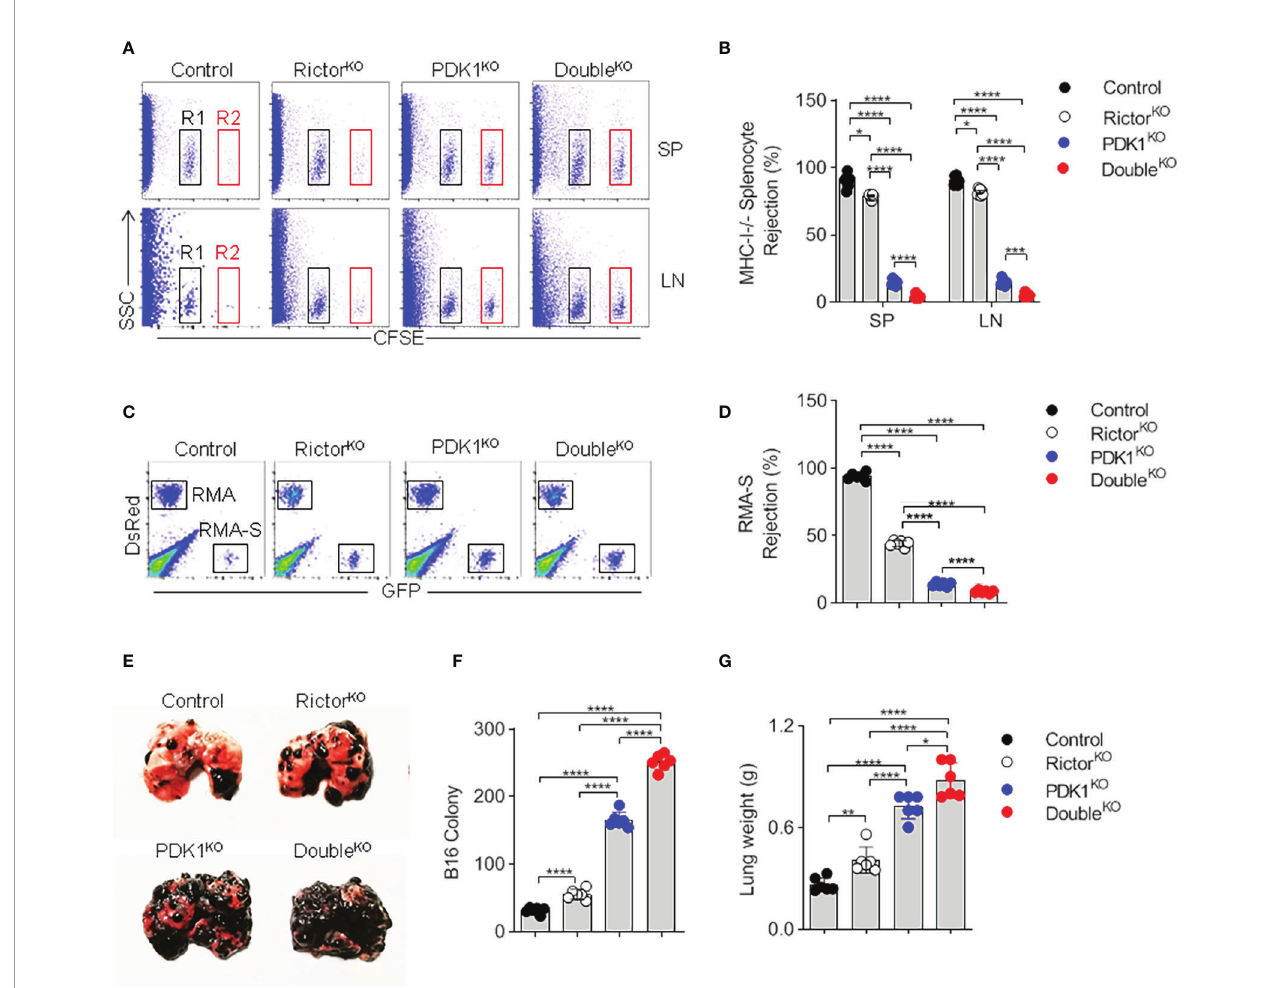
FIGURE 4 | NK cells fail to mediate in vivo surveillance in PDK1/Rictor-de fi cient mice. (A) Representative fl ow cytometry plot of CFSE + cells obtained from the SP and Lymph nodes (LN) of the indicated recipient mice at 18 h after injection with an equal number of C57BL/6 and b 2m -de fi cient splenocytes labeled with various concentrations of the cytosolic dye CFSE. R1, CFSE-low splenocytes from C57BL/6 mice; and R2, CFSE-high splenocytes from b 2m -de fi cient mice. (B) The percentages of rejected b 2m -de fi cient splenocytes from the SP and LN of the indicated recipient mice. (C) Representative fl ow cytometry plot of injected RMA-S cells in the peritoneal cavity at 18 h after intraperitoneal injection of the indicated mice with a mixture of NK cell-sensitive RMA-S cells expressing green fl uorescent protein (GFP) together with NK cell-resistant RMA cells expressing the fl uorescent protein DsRed. (D) The percentage of rejected RMA-S cells. (E – G) B16 metastasis assay, the indicated mice were injected intravenously with 2 × 10 5 B16 cells. The mice were sacri fi ced 14 day later, and the lung weights and numbers of tumor nodules were counted. Each symbol represents an individual mouse. Data are shown as means ± SD and represent one of three independent experiments, n ≥ 3 for each experiment. *p < 0.05, **p < 0.01, ***p < 0.001, ****p <